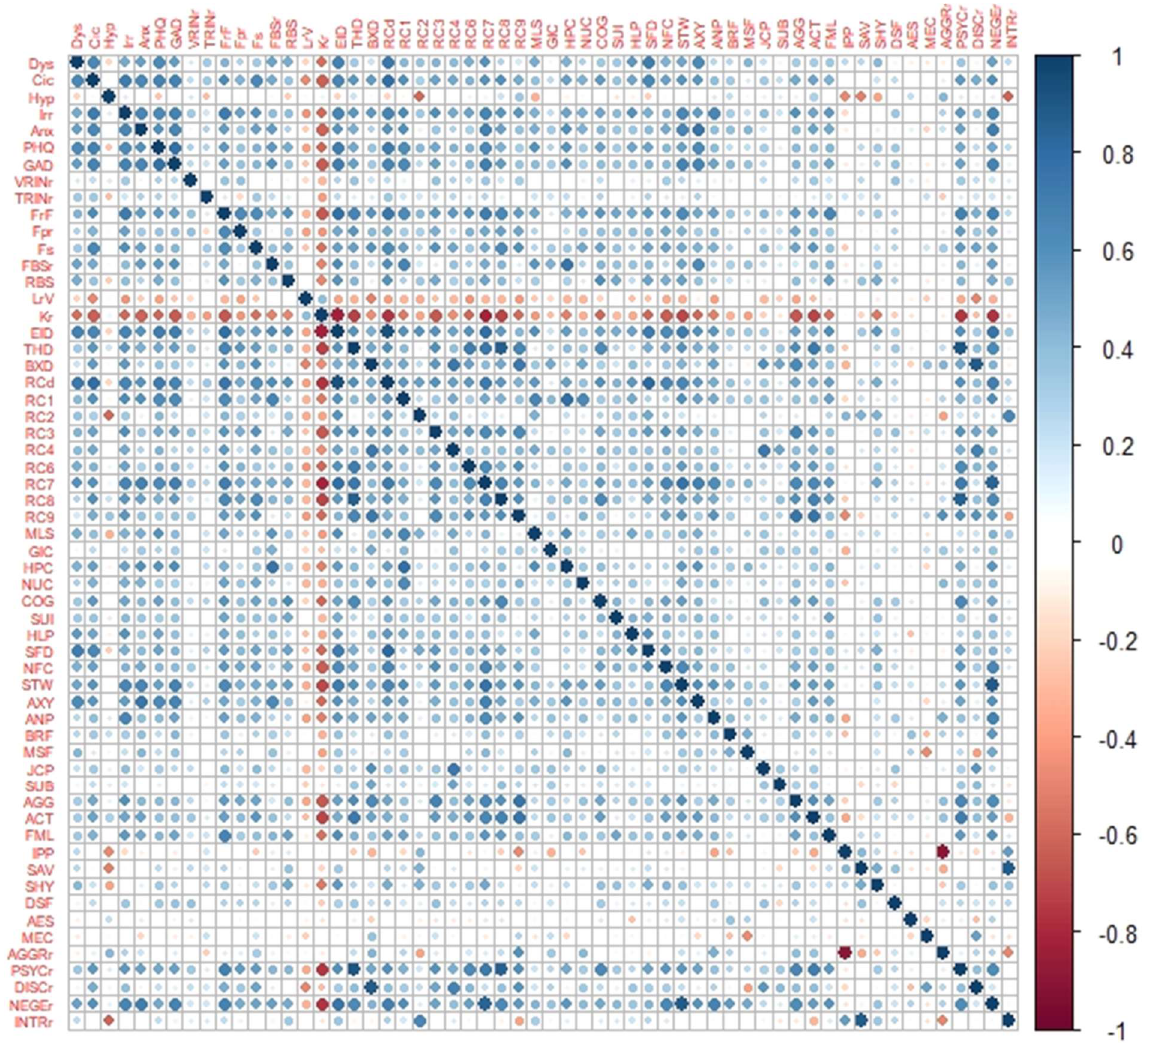
Figure 3. TEMPS–A , PHQ–9 , GAD-7 and MMPI–2–RF score correlation matrix. TEMPS–A: Figure 3. TEMPS–A, PHQ–9, GAD-7 and MMPI–2–RF score correlation matrix. TEMPS–A: